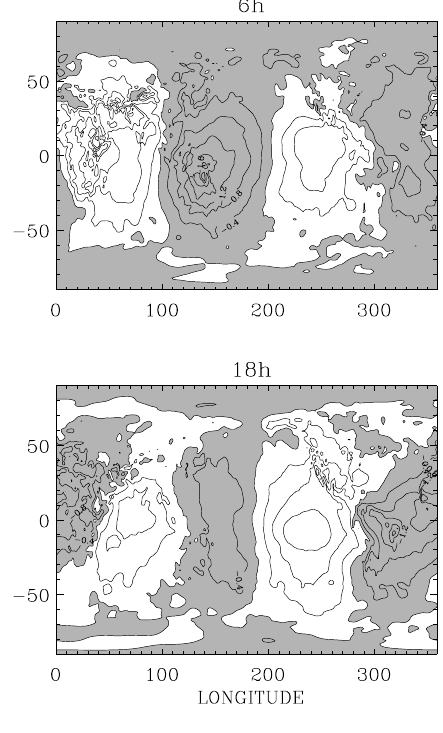
Fig. 3. As in Fig. 1 but showing climatological daily cycle for